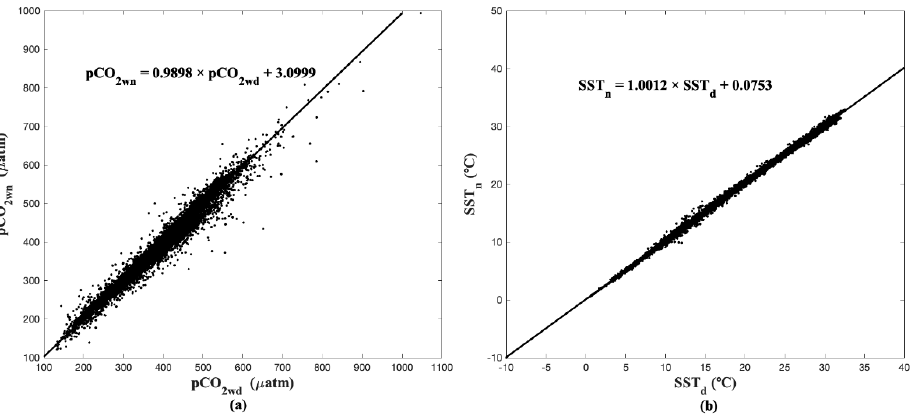
Figure 8. Spatial distribution of correlation coefficients between calculated diurnal and nocturnal CO 2 fluxes.